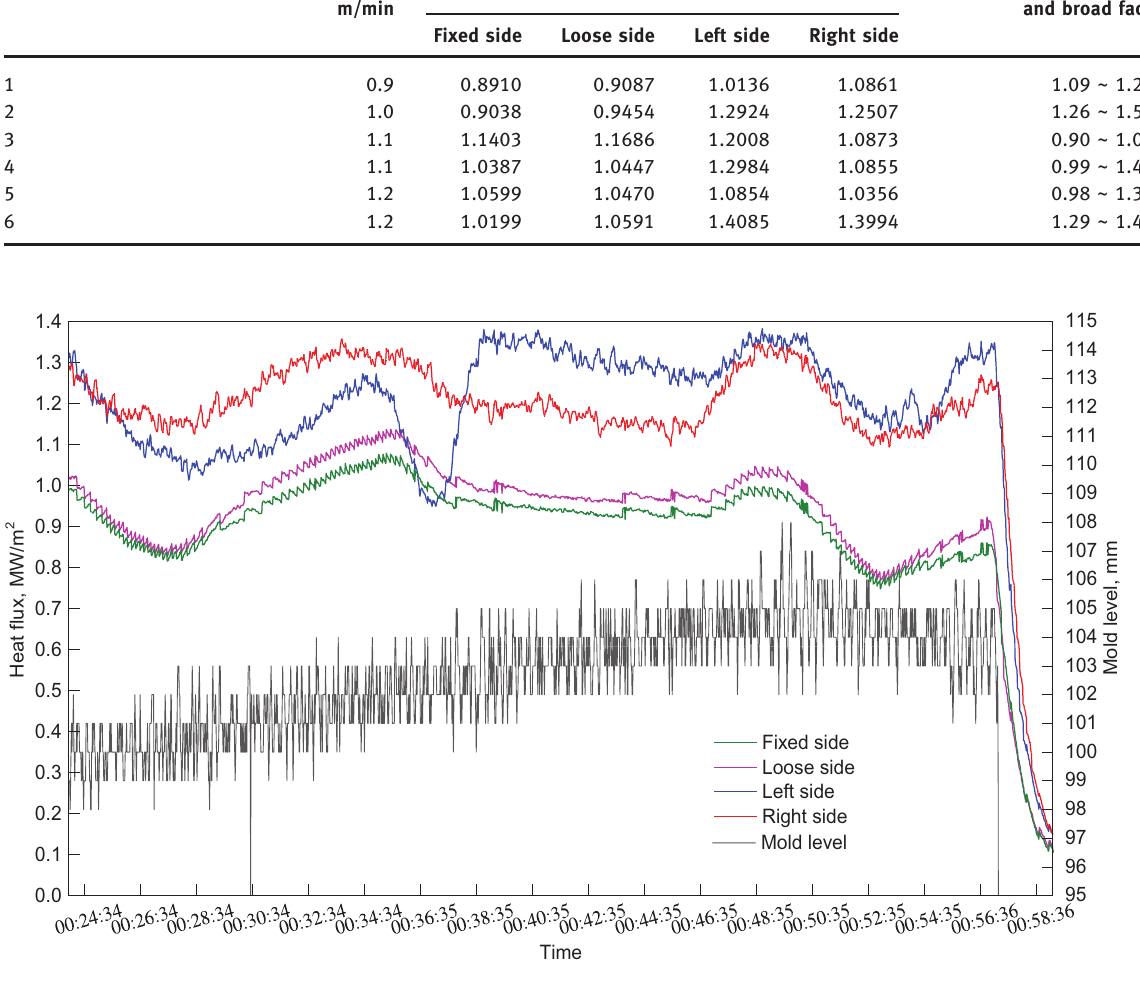
Table 4: Average heat flux in 3min before a sticker breakout. Sticker breakout sample